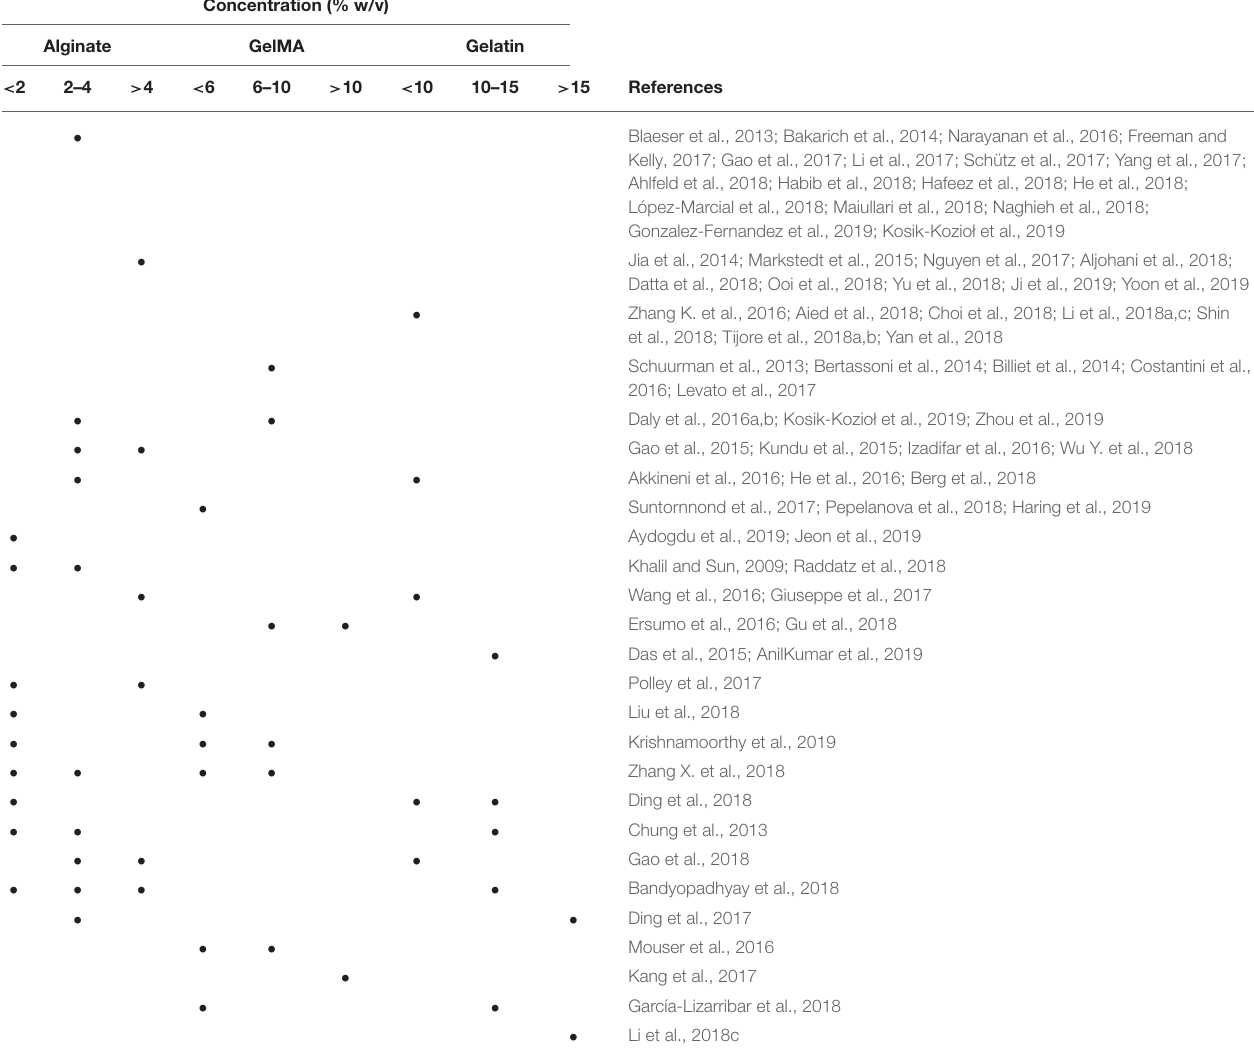
TABLE 1 | Concentrations of most used materials (alginate, GelMA, and